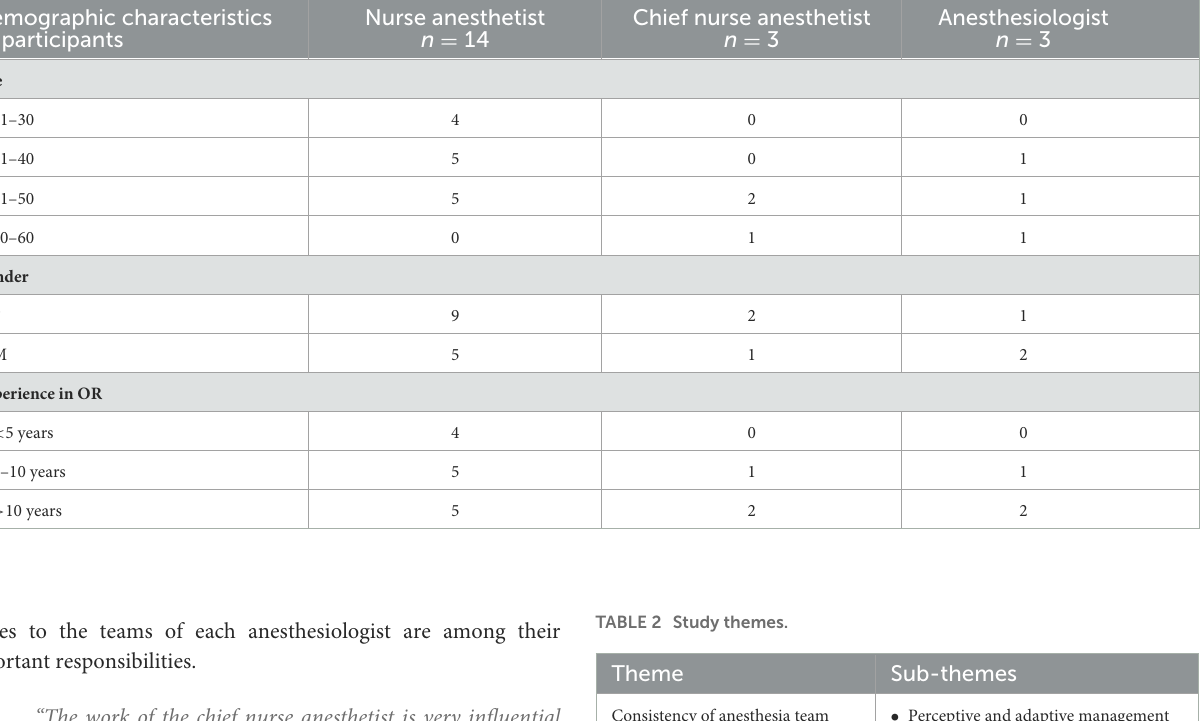
TABLE 1 Demographic characteristics of participants.